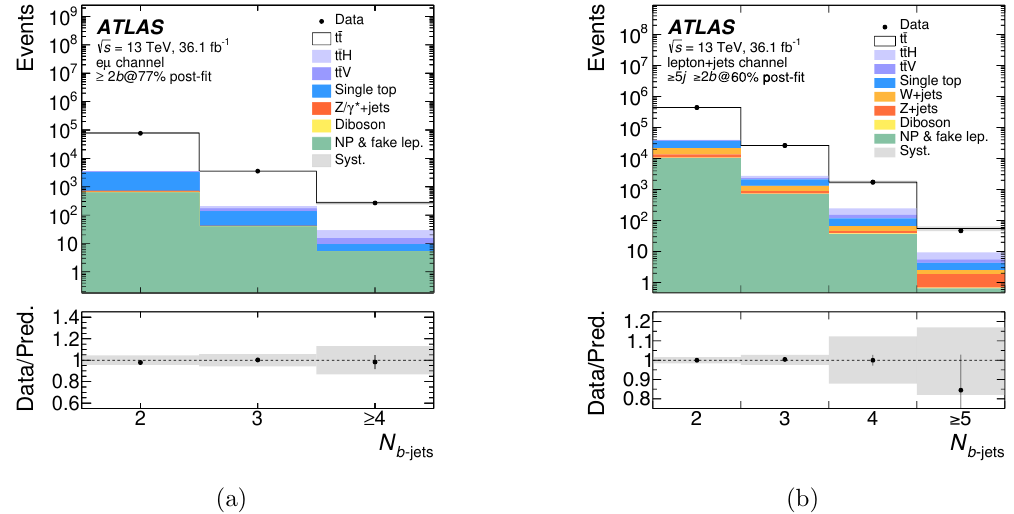
Figure 5. Comparison of the data distributions with predictions, after applying scale factors, for the number of b -tagged jets, in events with at least 2 b -tagged jets, in the (a) e(cid:22) and (b) lepton + jets channels. The systematic uncertainty band, shown in grey, includes all uncertainties from experimental sources.